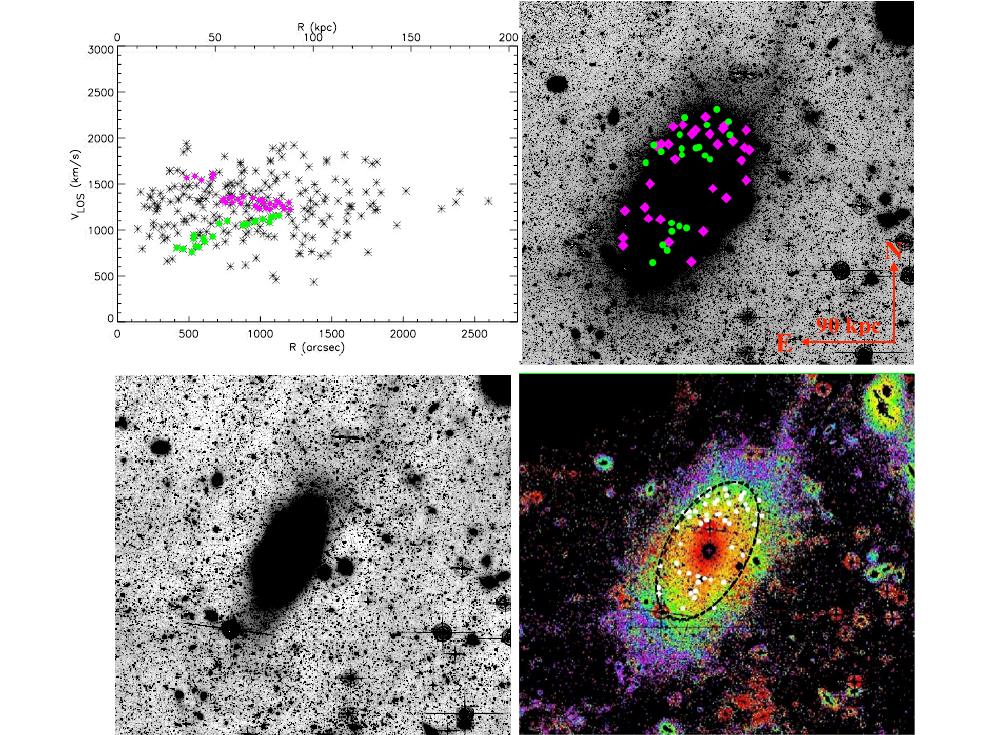
vs. major axis distance ( R ), for all Figure 3. ( Top-Left ): Projected phase-space, V LOS spectroscopically confirmed PNs (black asterisks) in the halo of M87. Green circles and magenta diamonds show the PNs associated with the cold secondary peaks in the LOSVD as identified by the GMM; ( Top-Right ): V-band image of a 1 . 6 × 1 . 6 deg 2 centred on M87 from Mihos et al. [22]. Full green circles and magenta diamonds indicate the spatial position = 1254 kms − 1 , of the M87 halo PNs in the chevron substructure, above and below V LOS , edge which is the LOSV at the edge of the chevron; ( Bottom-Left ): Unsharped masked image of M87 median binned to enhance faint structures. The crown-shaped substructure is visible at distance of ∼ 60 − 90 kpc along the major axis, NW of M87; ( Bottom-Right ): (B-V) colour image of M87 from Mihos et al. [22] with chevron PNs overplotted (white dots). The dashed ellipse indicates the isophote at a major axis distance of 90 kpc. The crown is found in a region where the (B-V) colour is on average 0.8, that is bluer then the average red colour on the minor axis, at the same